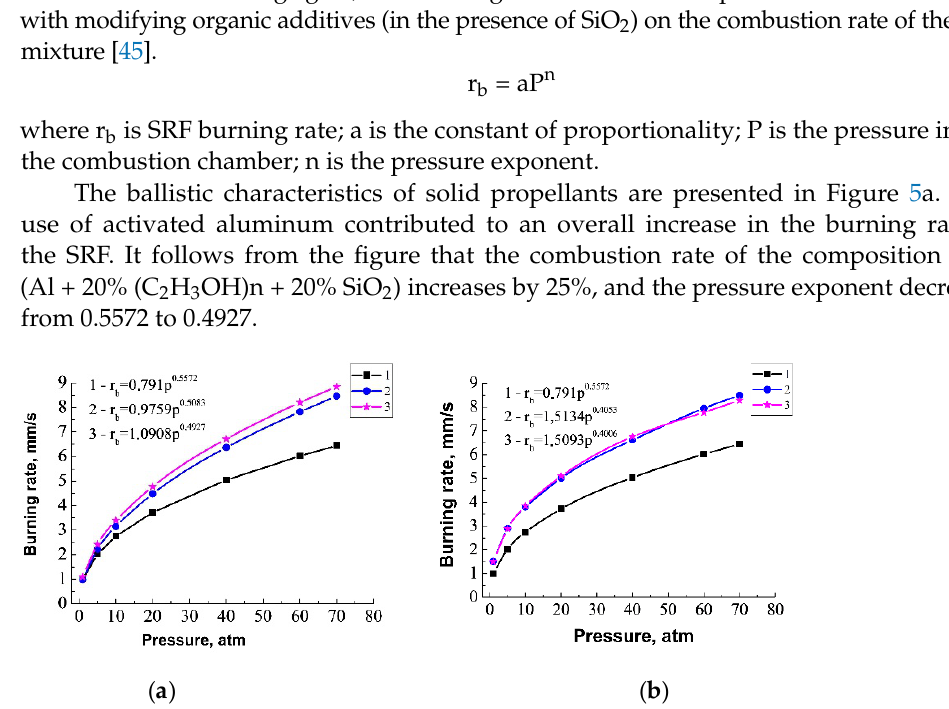
Figure 5. Change in the burning rate for PA/HTPB/Alx fuels with non-activated aluminum (1), after MCT with a composite ( a )—[Al+20%(C 2 H 3 OH)n +5%SiO 2 ] (2) and [Al+20%(C 2 H 3 OH)n +20%SiO 2 ] (3) and with composite ( b )—Al+3% C 17 H 35 COOH +5%SiO 2 (2) and Al+3%C 17 H 35 COOH +20%SiO 2 (3)